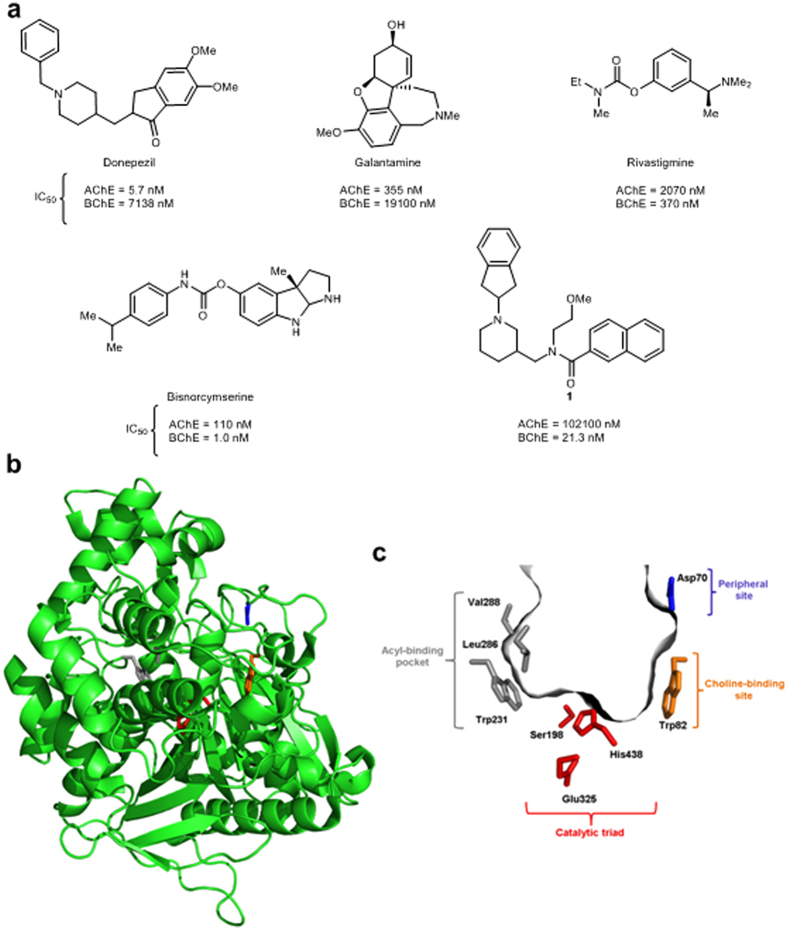
ChE inhibitors and structures of huBChE and its active site gorge.(a) Structures and IC50 values against the ChEs of the currently approved drugs for the treatment of AD symptoms that exploit ChE inhibition (donepezil, galantamine, rivastigmine) and selective huBChE inhibitors (bisnorcymserine and compound 1). (b) The overall structure of huBChE (PDB code 4TPK) shown as a green cartoon with the key amino acids of the active site shown as sticks. (c) The active site gorge of huBChE shown as a gray surface. The principal contributors to the peripheral site (Asp70; blue), the choline-binding site (Trp82; orange), the catalytic triad (Ser198, Glu325, His438; red), and the acyl-binding pocket (Trp231, Leu286, Val288; gray) are shown as sticks.